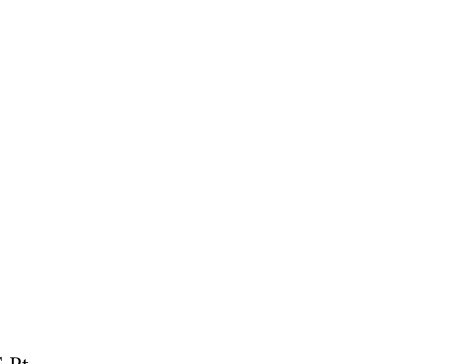
Figure 1. TEM image of ( a ) CNT-Ag, and SEM image of ( b ) CNT-Pt.